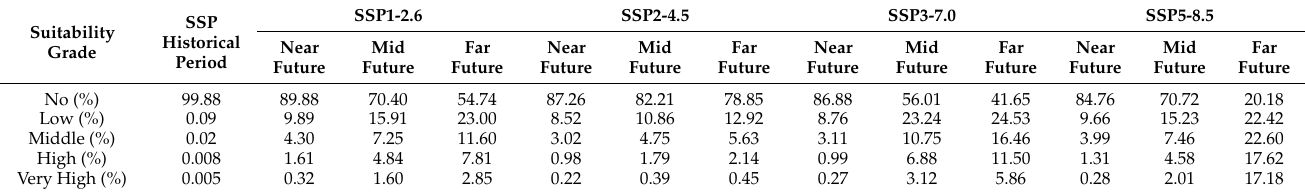
Table 4. The ratio of predicted area to total land area of South Korea for Q. acuta under climate